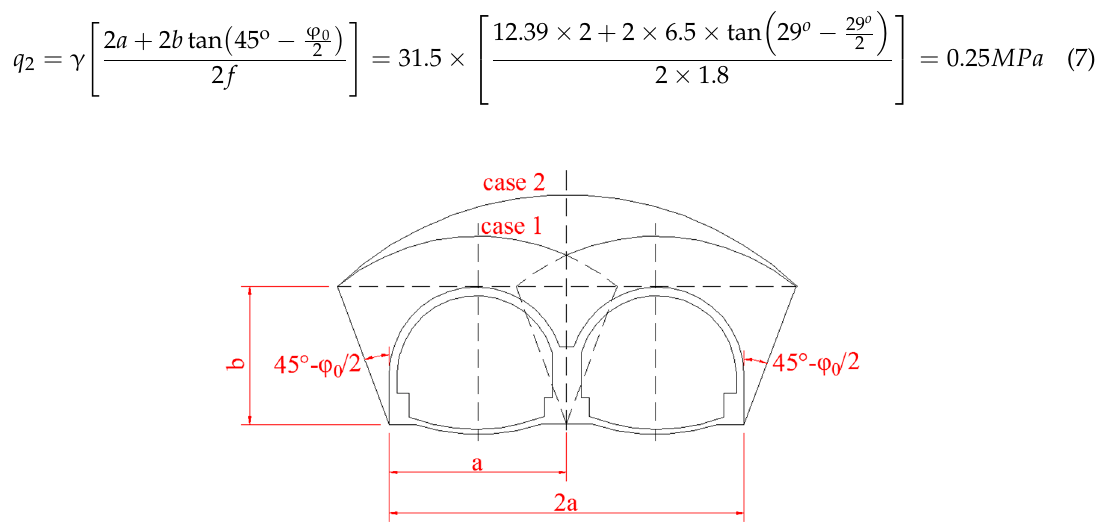
Figure 15. Schematic diagram of the tunnel balance arch curves of the double ‐ arched tunnel in two cases.